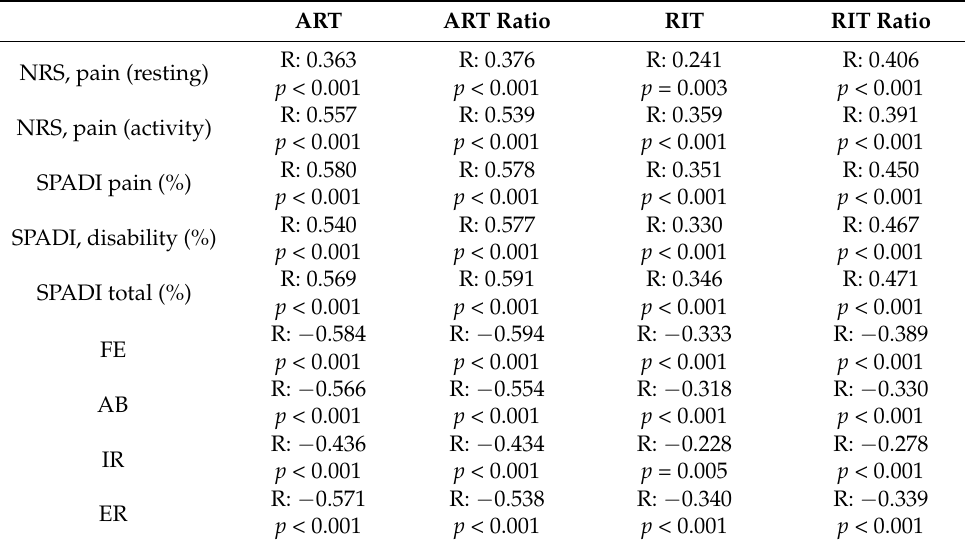
Table 4. Repeated measures correlation between ultrasound parameters and clinical